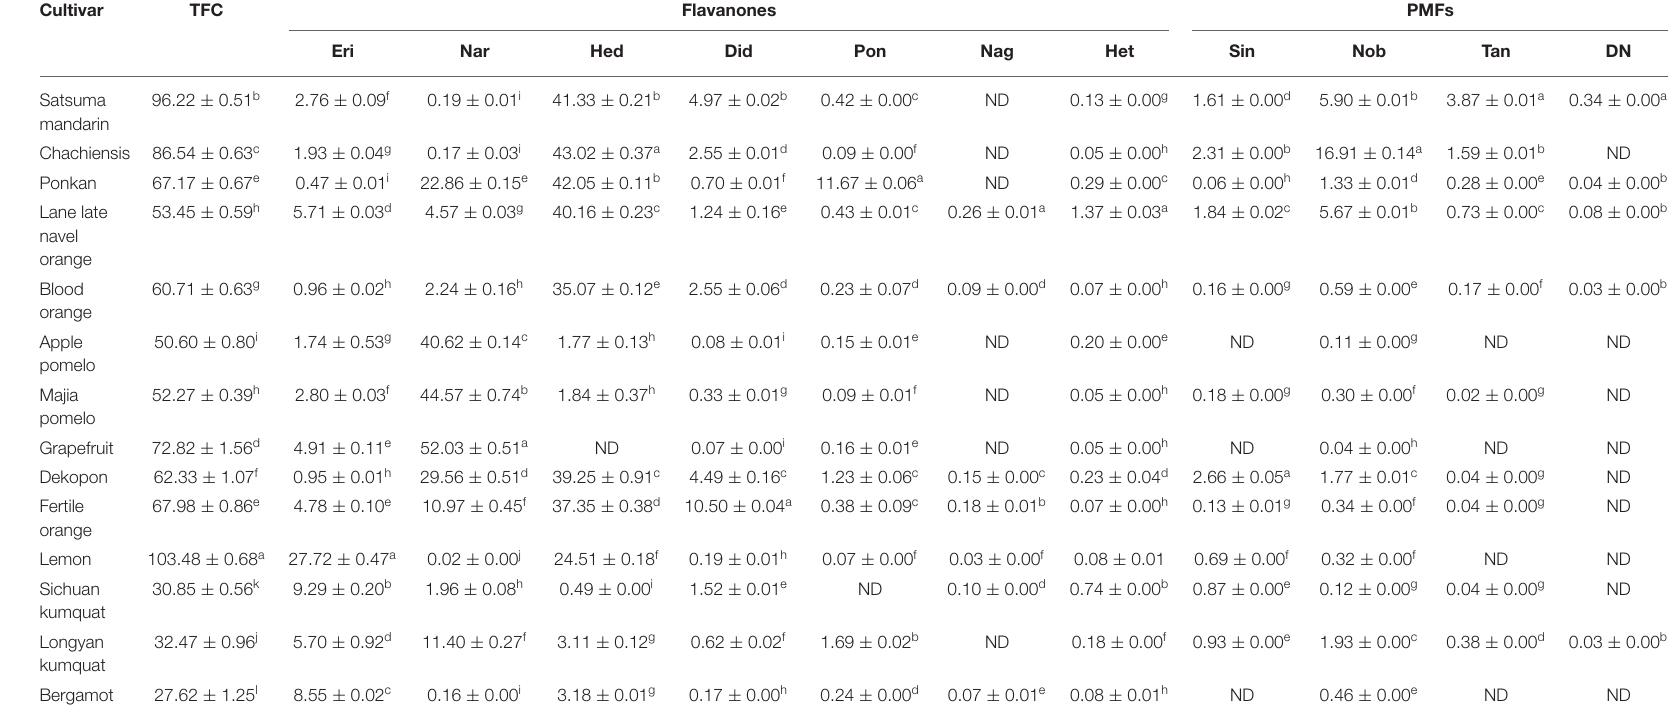
TABLE 1 | Contents of total flavonoids, flavanones and PMFs in CPFEs (mg/g DW).